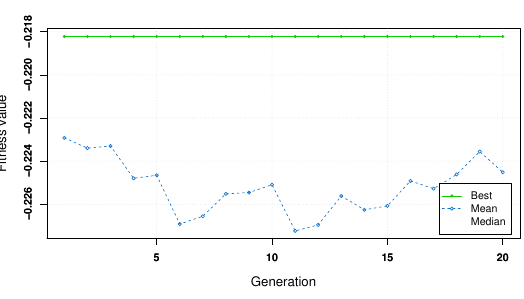
Figure 6. Scenario #2.